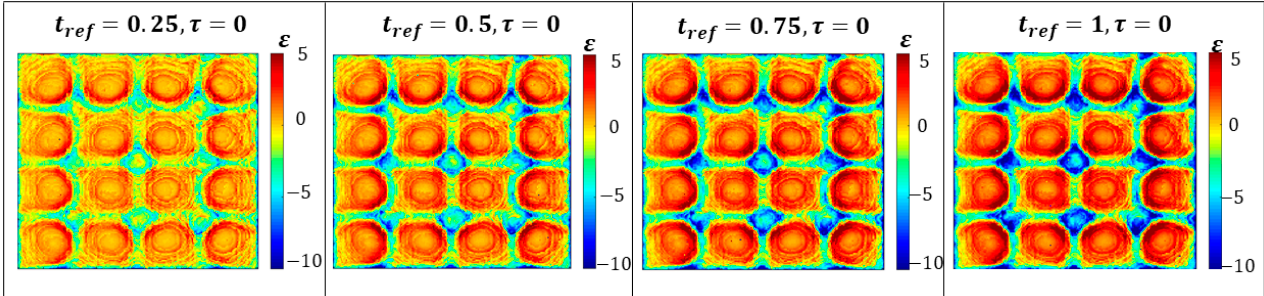
Figure 18. Case III: 𝜺 map for four different time matrices to be tracked.